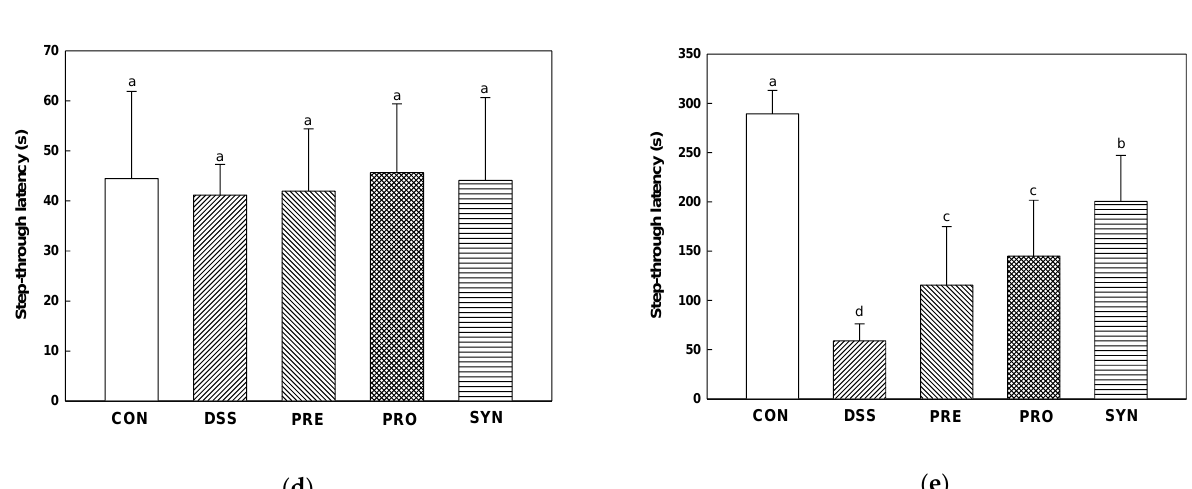
mice. Number of arm entries ( a ), alternation behavior ( b ) and path motion ( c ) on Y-maze test, and latency during habituation ( d ) and step-through latency ( e ) on passive avoidance test. The results were presented as the mean ± SD ( n = 5). Data were statistically considered at p < 0.05, and different lowercase letters indicate significant differences between groups.